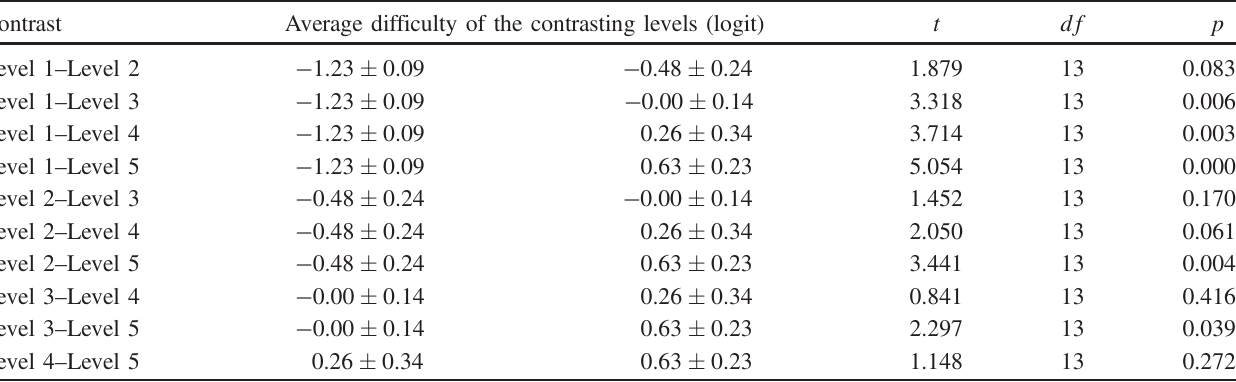
TABLE III. Contrasts between the average difficulty of the construct map levels. Contrast